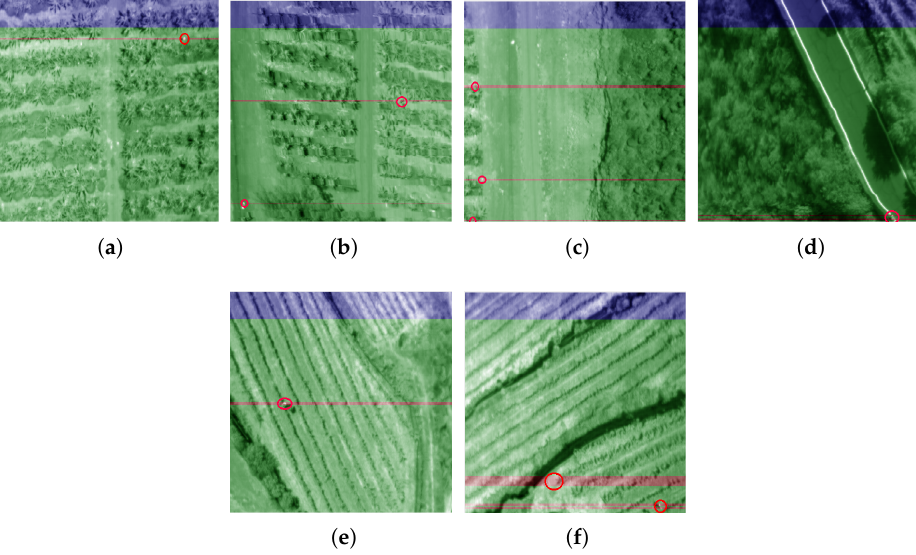
Figure 9. Anomaly detection results using compressed–decompressed images for input parameters N bits = 12, BS = 1024 and CR = [12, 16, 20]. Lines in blue color represent the n f frames employed